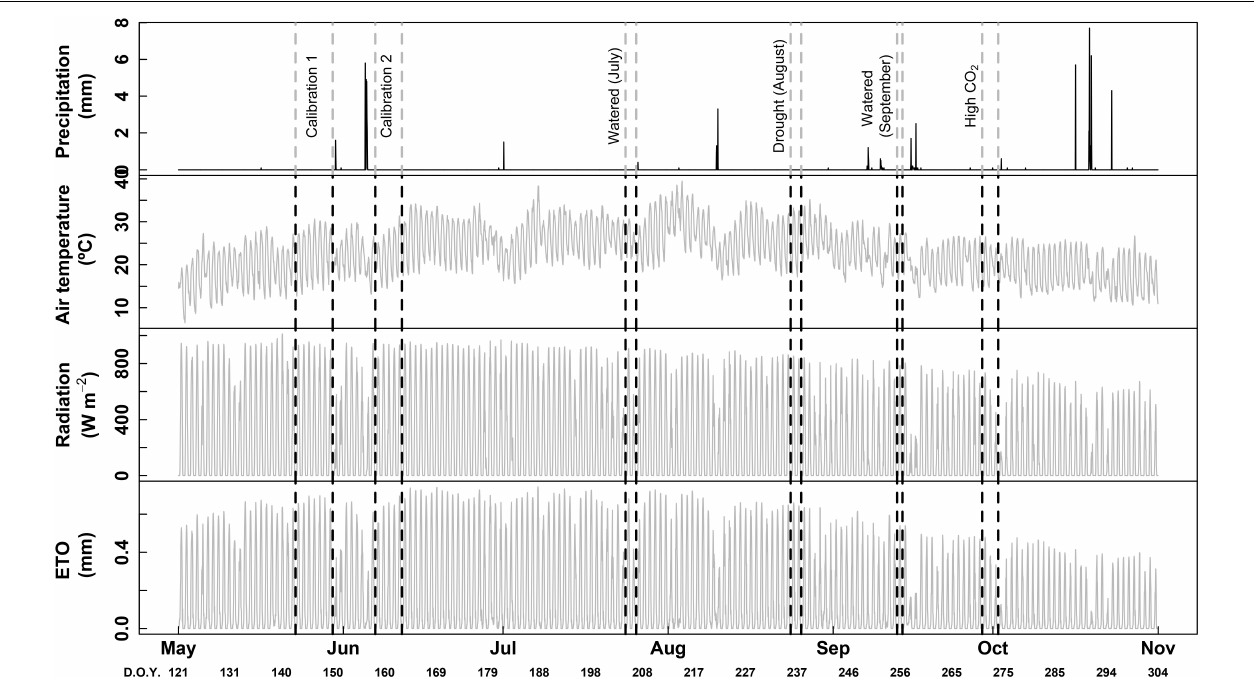
FIGURE 1 | Hourly raw data of precipitation, air temperature, radiation and ET 0 (potential evapotranspiration). Vertical dotted lines indicate dates of each session of measurements performed in this study, with the corresponding treatments. D.O.Y. for day of the year.